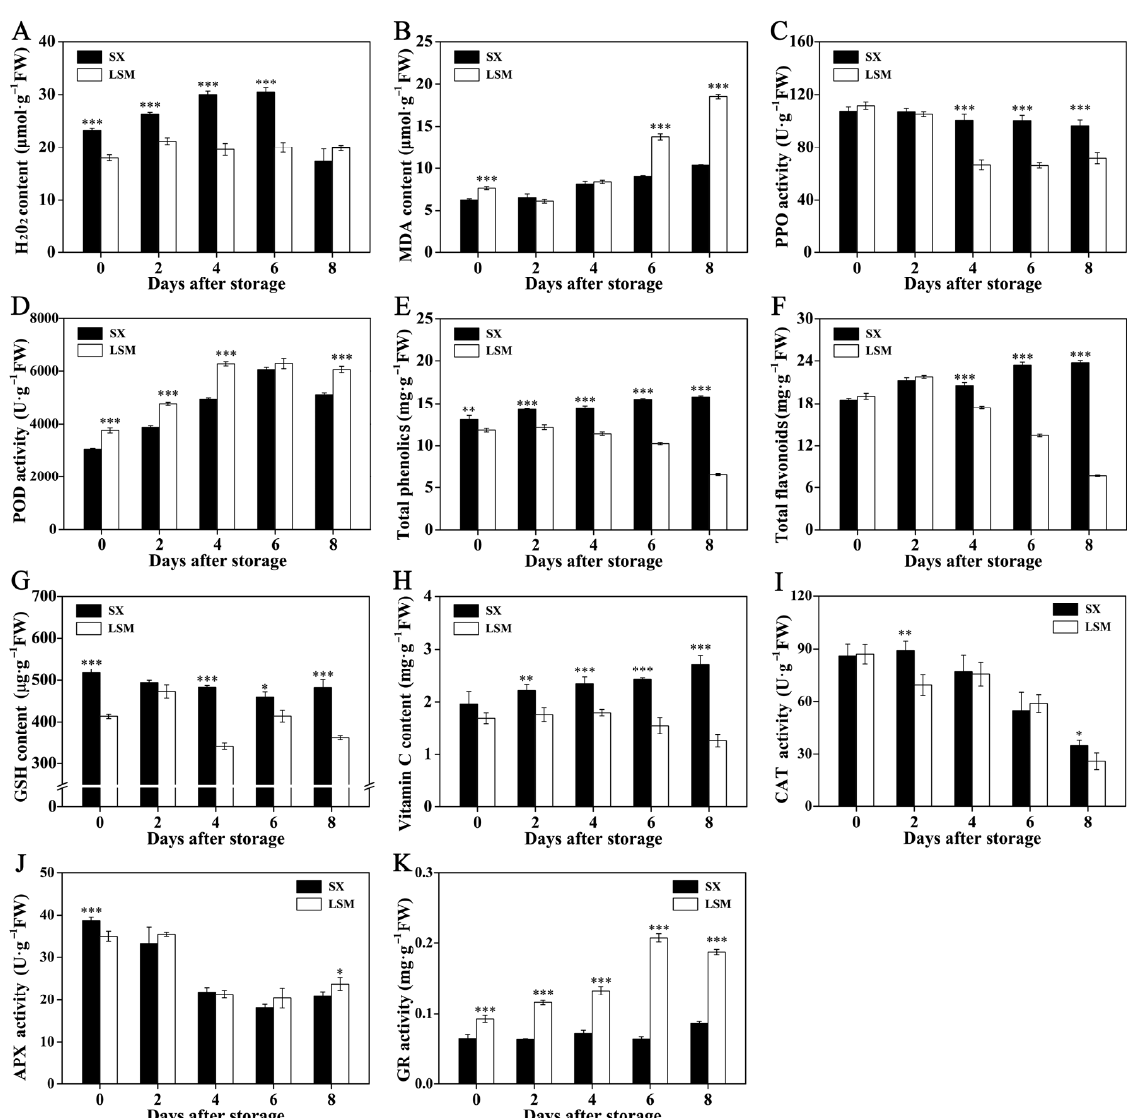
Figure 2. The content of H 2 O 2 and antioxidants as well as activities of radical-scavenging enzymes in 'Shixia' and 'Luosanmu' longan pericarp during the room-temperature storage. ( A ) H 2 O 2 content, ( B ) MDA content, ( C ) PPO activity, ( D ) POD activity, ( E ) total phenolic content, ( F ) total flavonoid content, ( G ) GSH (reduced glutathione) content, ( H ) vitamin C content, ( I ) CAT (catalase) activity, ( J ) APX (ascorbate peroxidase) activity, ( K ) GR (glutathione reductase) activity. *: 0.01 < p < 0.05: **: 0.001 < p < 0.01; ***: p < 0.001. FW: fresh weight.